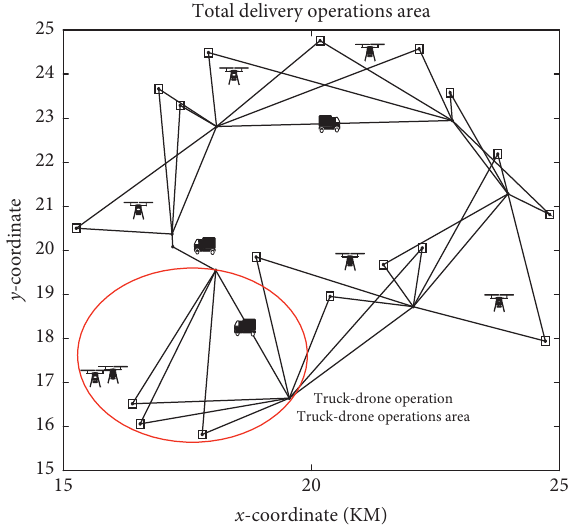
Figure 1: Total delivery operations area proportional to the truck- drone operations